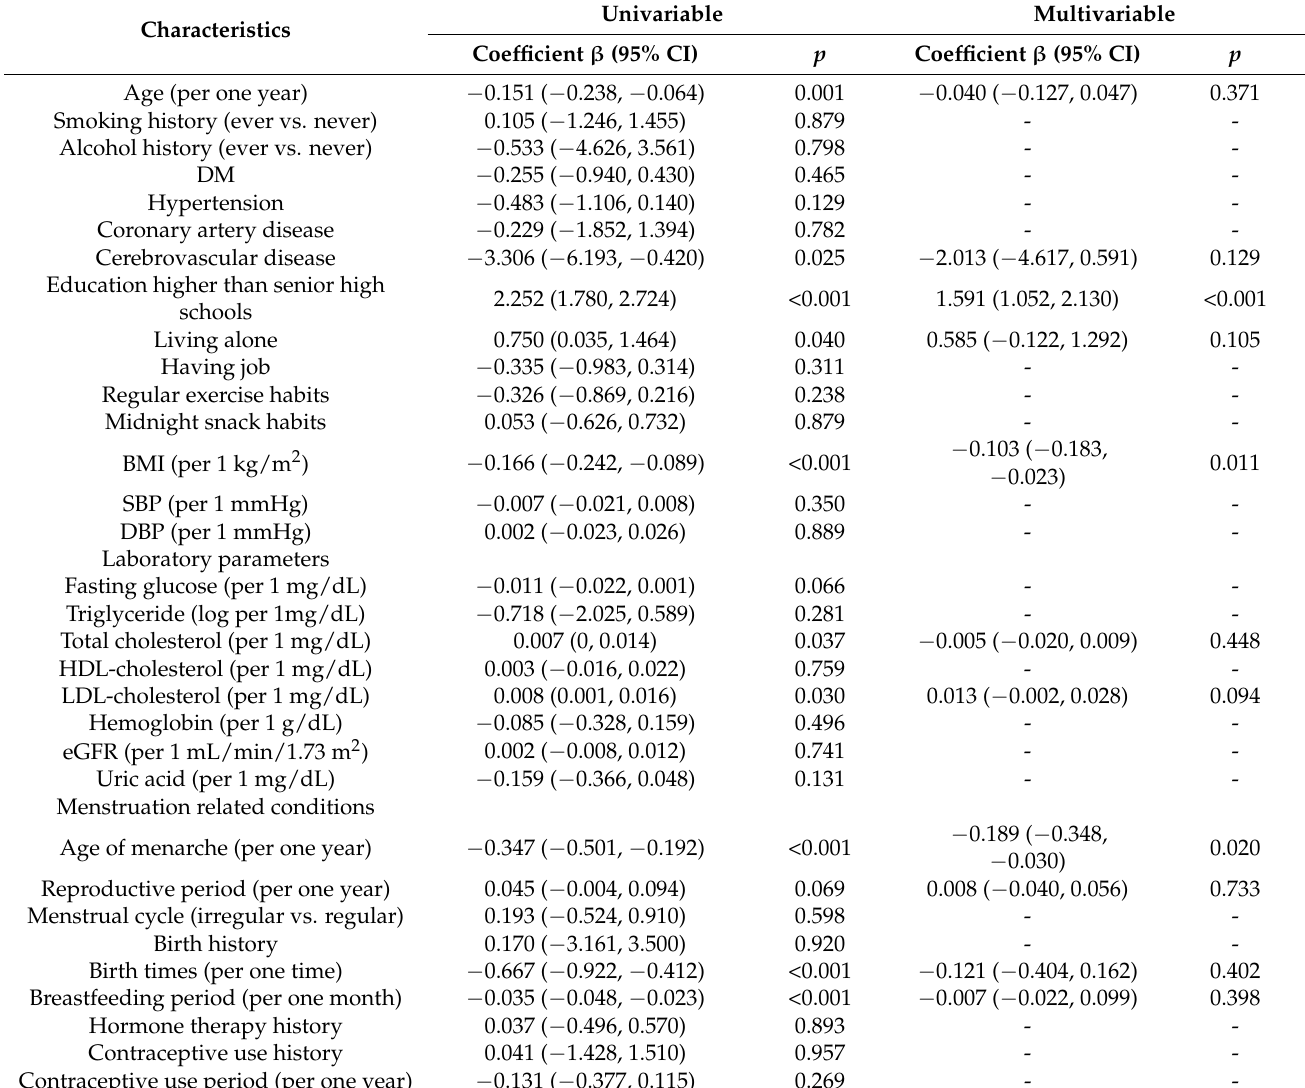
Table 4. Determinants total MMSE scores using linear regression